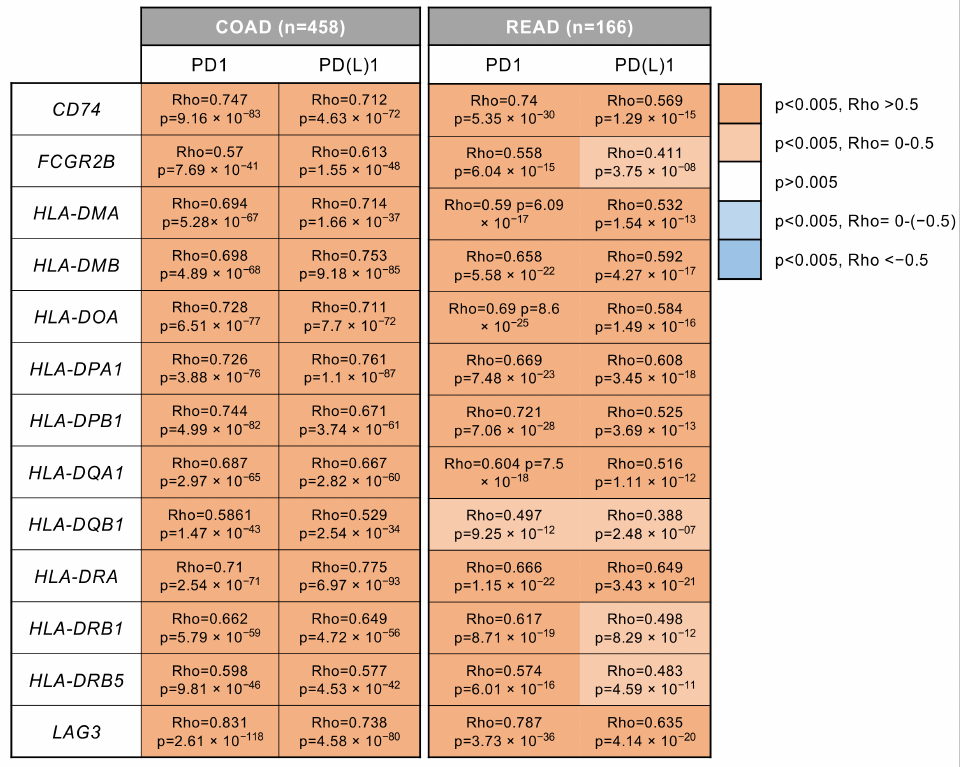
Figure 4. Positive correlation between identified upregulated genes and PD1/PD(L)1 expression. Heatmap indicating the Rho and Spearman’s p -value of the correlation between the expression of upregulated genes ( CD74 , FCGR2B , HLA-DMA , HLA-DMB , HLA-DOA , HLA-DPA1 , HLA-DPB1 , HLA-DQA1 , HLA-DQB1 , HLA-DRA , HLA-DRB1 , HLA-DRB5 , and LAG3) and PD1 or PD(L)1 in COAD (n = 458) and READ (n =